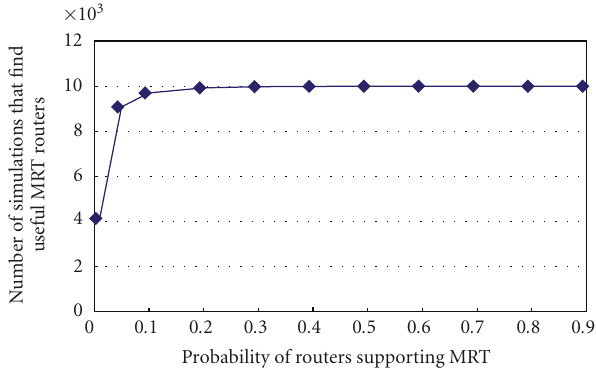
Figure 7: Number of simulations that find an MRT router.